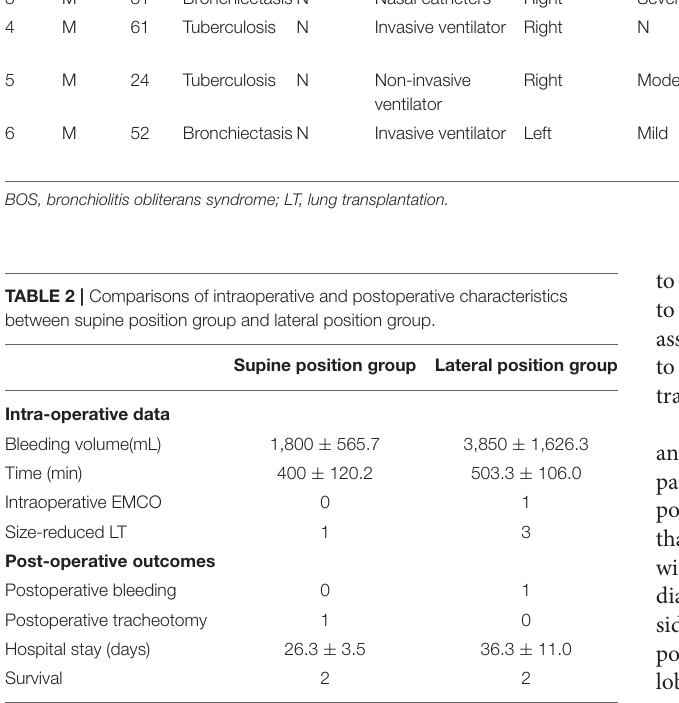
The mean duration of in-hospital stay in the lateral